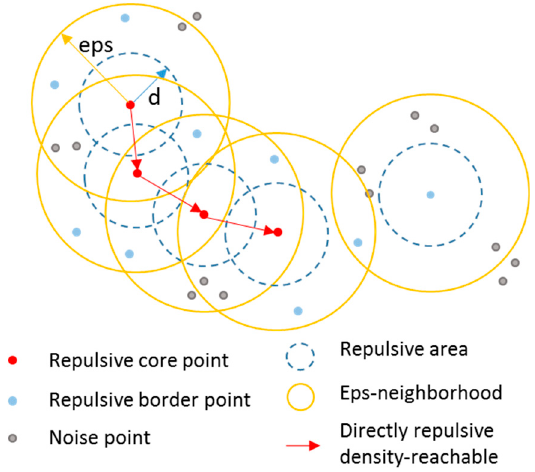
Figure 3. Basic concepts relating to repulsive clusters.